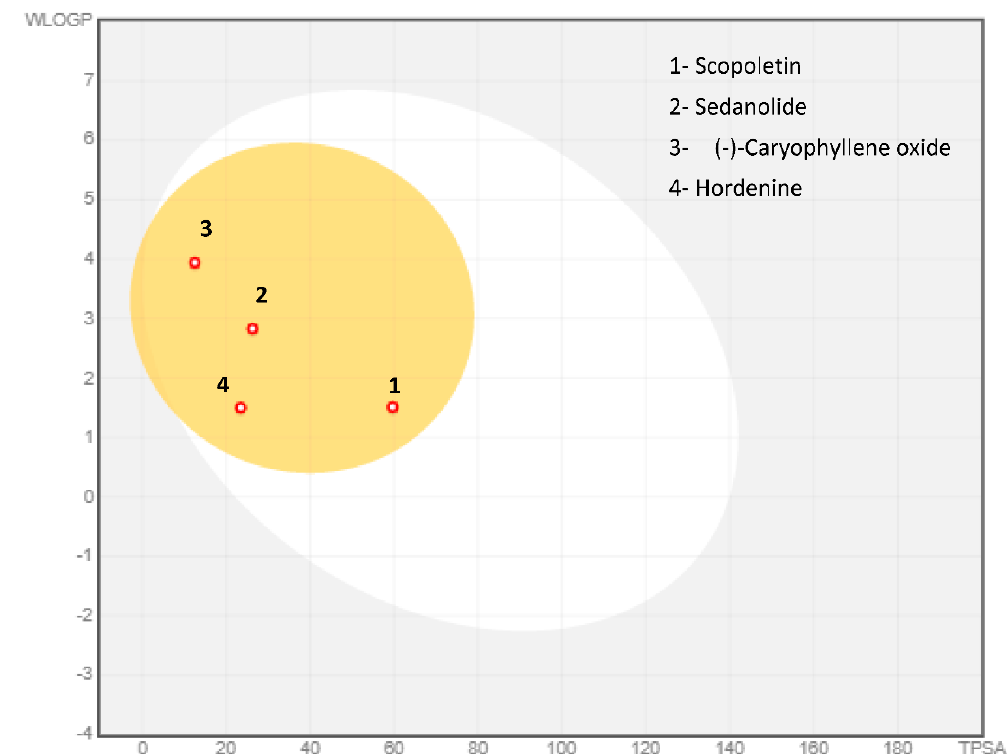
Figure 8. BOILED-Egg model of the volatile constituents using the Swiss ADME predictor.